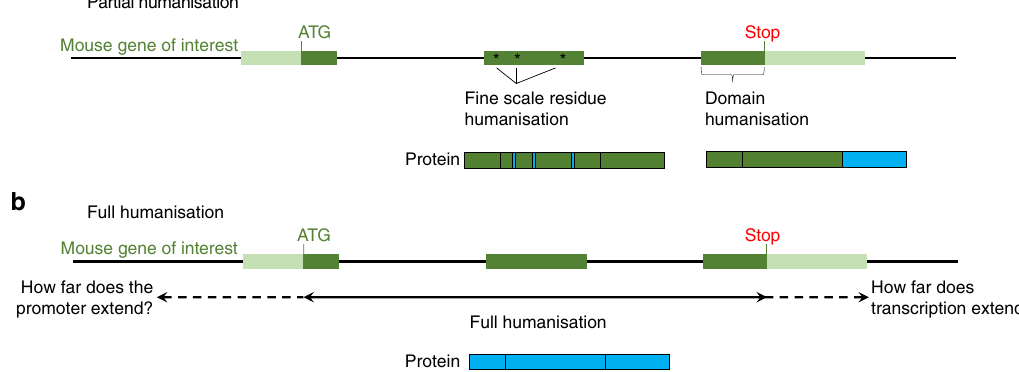
Fig. 2 How far to humanise. A summary of considerations when deciding on the extent of targeted genomic humanisation for a given gene of interest. Dark green boxes represent exons, lines between exons are introns, light green boxes are UTRs and blue regions represent humanisation. a Partial humanisation typically involves humanising speci fi c residues and/or domains of interest. Fine-scale humanisation of speci fi c amino-acid residues can be performed in isolation if they have known biochemical differences from mouse to human, or if only a small number of residues need to be altered to achieve a human protein sequence. Speci fi c domains or exons can be humanised if, for example, they are known to be critical for human disease. Examples of translated protein products are given. b Full humanisation involves humanising the whole gene, including introns, to attain translation of the full human protein, potentially including human-speci fi c splicing patterns, and for maximum translational potential. 5 ʹ and 3 ʹ -UTRs, promoters, and other regulatory sequences can be included, on a case-by-case basis, if understanding of gene regulation is the question at hand, if gene clusters are to be humanised or if pathogenic mutations fall within such fl anking